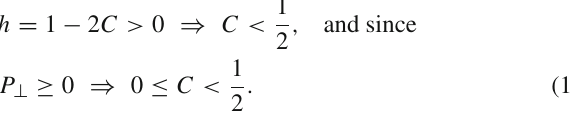
plot. In this particular case, near the boundary of the configuration, we have ( m / r ) (cid:4) < 0 and a physically reasonable metric coefficient. Thus, ( m / r ) (cid:4) > 0 should be considered as a sufficient but not a necessary